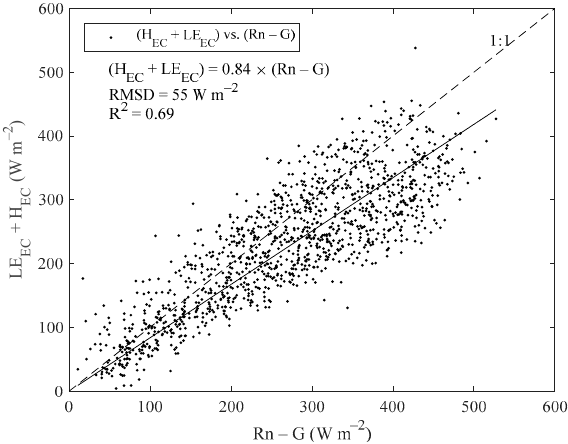
Figure 3. EC surface energy balance lack of closure based on a comparison between turbulence fluxes (LE + H) and available energy (Rn − G). RMSD, root mean square difference.